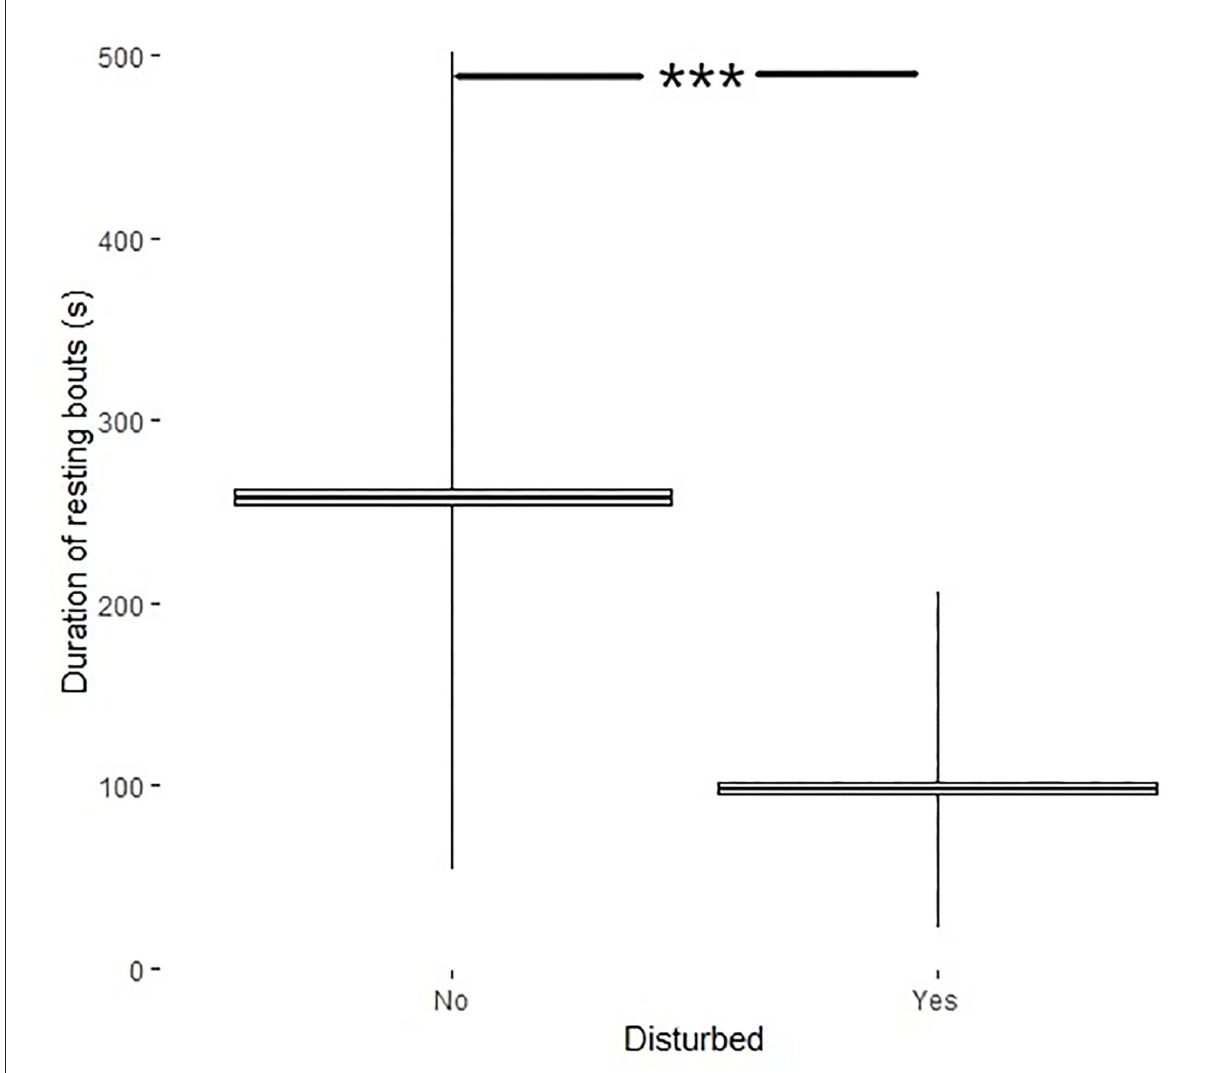
FIGURE4 Duration of resting bouts (s, min–max + mean ± SE) if the bird was disturbed (yes) or not (no). *** Indicates significance level.